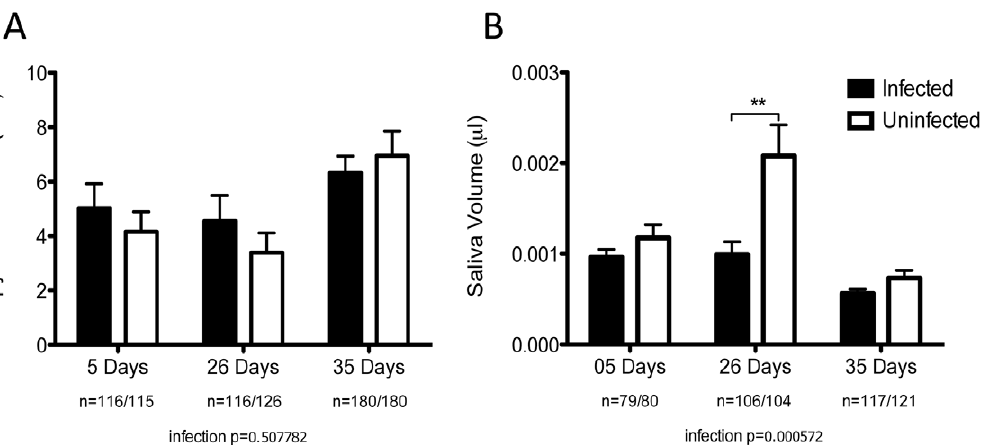
Figure 6. Apyrase content and saliva volume. Comparisons of apyrase and saliva volume of mosquitoes infected with Wolbachia (black bars) or tetracycline treated counterparts (white bars) of different ages (5, 26 and 35 days). A) Apyrase activity measured through the release of inorganic phosphate from ATP. B) Saliva volume measured through the sphere volume of saliva droplets. Number of replicates in each group and age are represented. Bars depict means 6 S.E.M. P values relate to univariate tests of significance derived from general linear models. ** indicates P , 0.01 from t-tests for the specific age category.